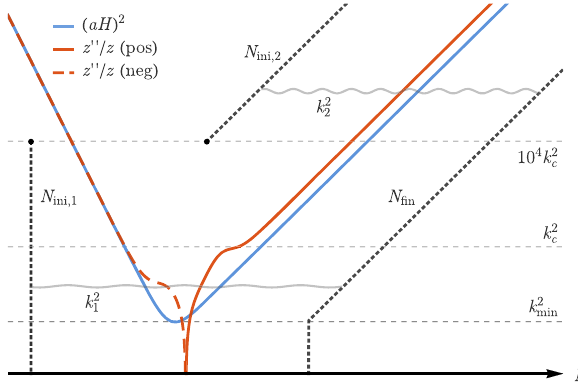
Fig. 3 The initial conditions for the numerical integration are set for each mode depending on whether the wave-number k is above or below 10 2 k c , where k c characterizes the bumps in the potential z (cid:10)(cid:10) / z around the transition to inflation. For k 1 < 10 2 k c the initial conditions are set at N ini , 1 well during the initial “stiff” epoch. For k 2 > 10 2 k c the initial conditions are set some N ini , 2 e-foldings before the mode exits the Hubble horizon during inflation. After the mode exits the horizon, at N fin , the numerical integration is stopped. For the modes with k < k min that never enter the horizon, the stopping time is the same as for k